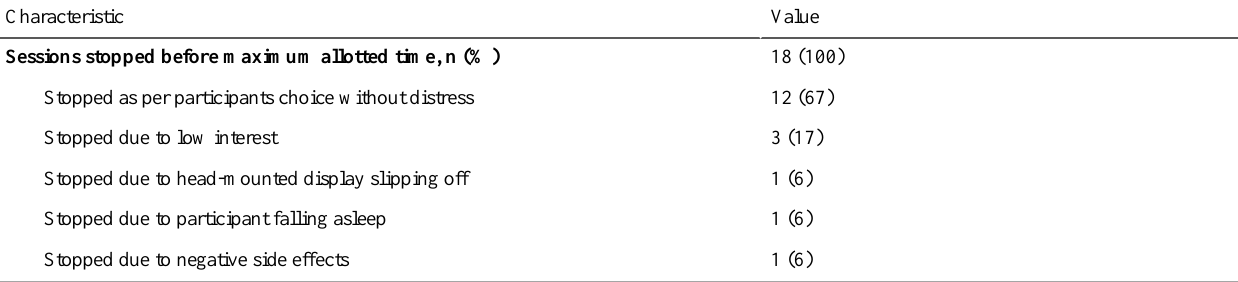
Table 3. Reasons for premature removal of virtual reality head-mounted display